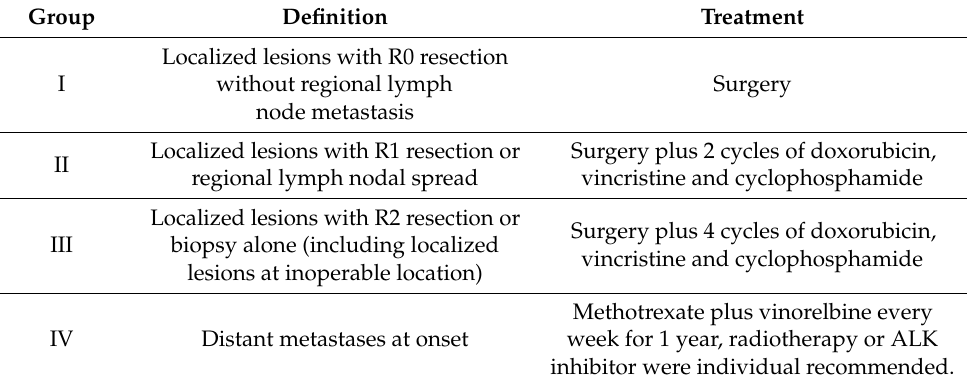
Table 1. Clinical group and treatment in China Children’s Medical Center